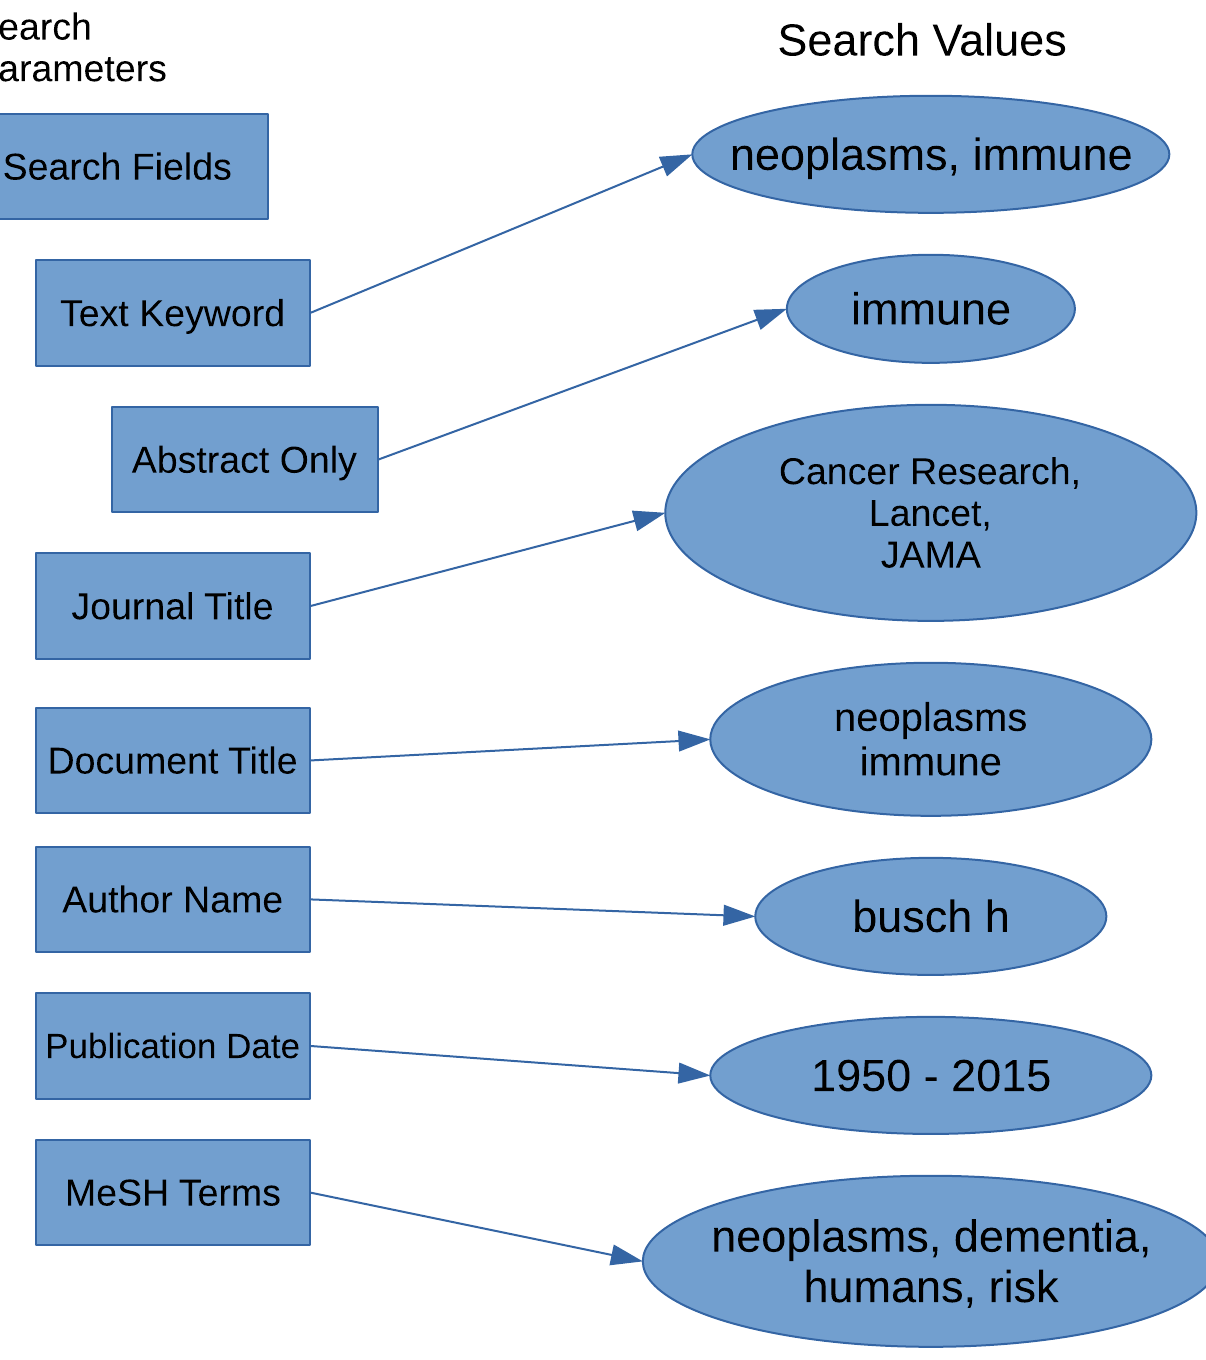
Fig 2. Search parameters. Comprehensive list of search values for the search parameters used for data collection.